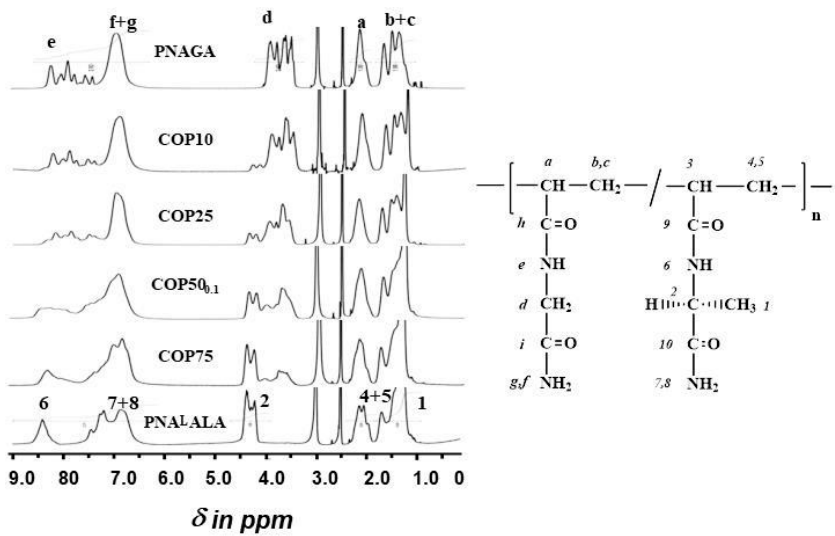
Figure 4. The 1 H-NMR spectra of homopolymers and copolymers in d6-DMSO at 100 ◦ C (left), and assignments of the resonances to the different protons present in NAGA units (numbers) and in NA L ALA ones (letters) (right). Table 1. PNAGA, PNAGA- co -NA L ALA, and PNA L ALA polymers obtained by radical